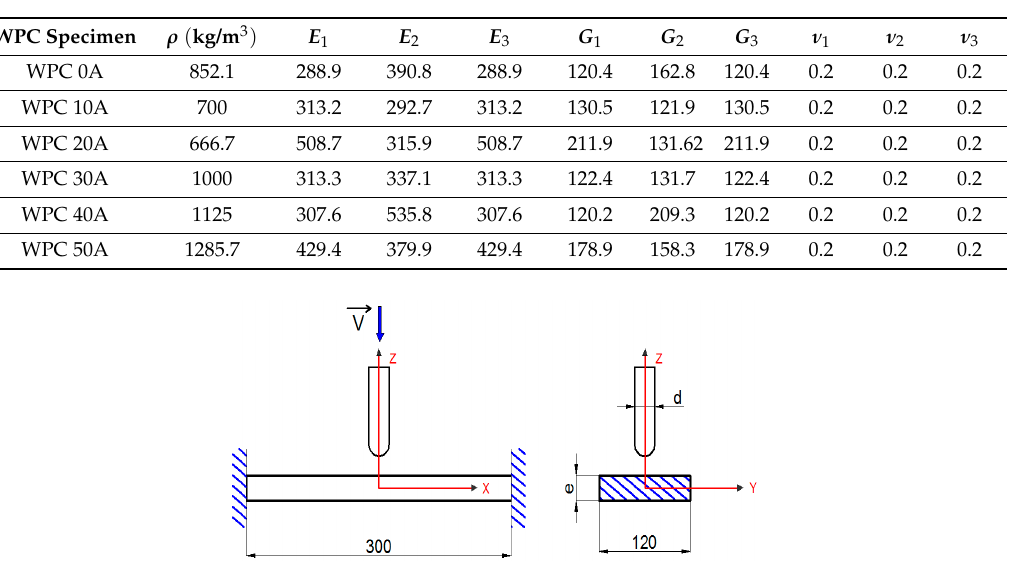
Figure 1. The modeled drop weight tests in the wood plastic composite (WPC) plate.